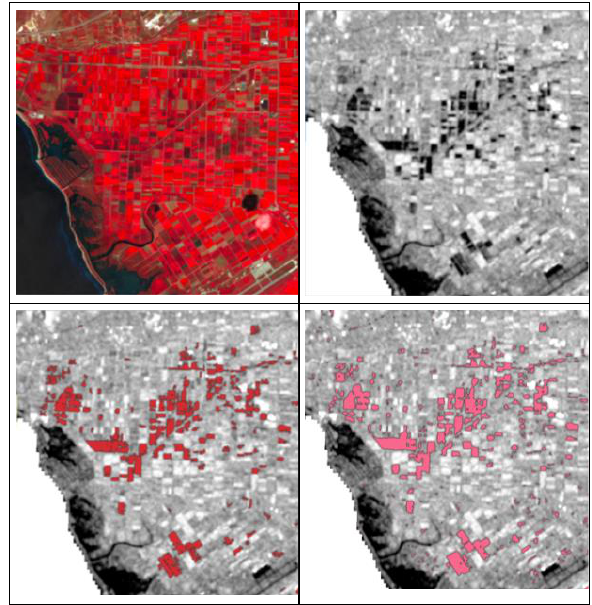
Figure 4. Sentinel-2 pre-event, pseudo-colour image visualisation (upper left), Sentinel-1 post-event processed image (upper right), Copernicus EMS vector output in red (lower left) and proposed methodology’s vector output in pink (lower right) over a subset of the area of interest.